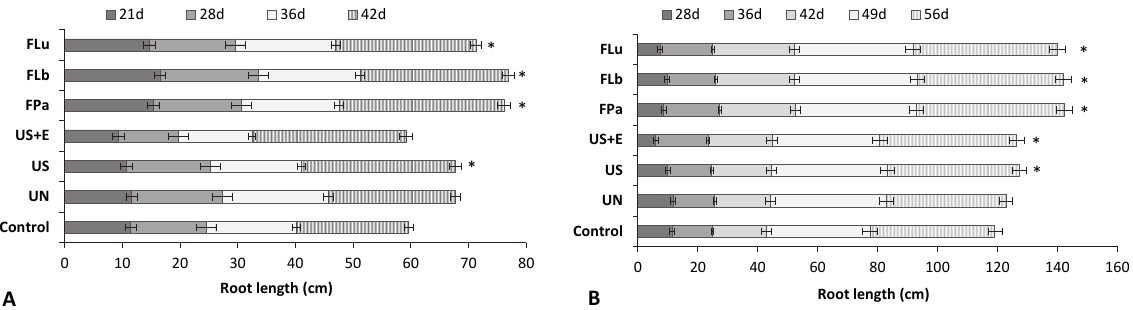
Figure 2. Influence of rice bran (RB) additives on bean ( A ) and tomato ( B ) root length. Control: PGS; PGS with RB: UN, untreated; US, ultrasonicated; US+E, ultrasonicated and enzyme ‐ hydrolyzed; F Pa , F Lb , F Lu , fermented with appropriate lactic acid bacteria strain. * significant at p < 0.05 compared to the controls.